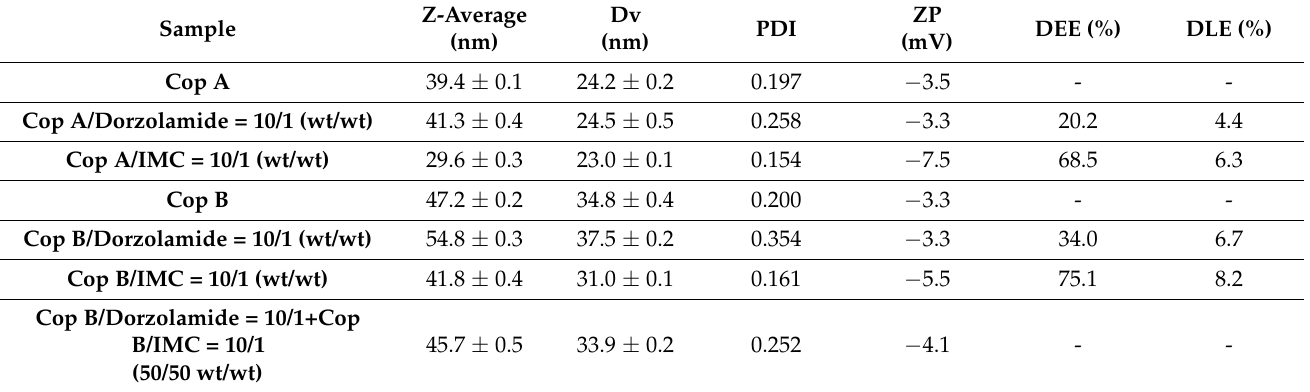
Table 1. Colloidal characteristics of freshly prepared suspensions of Cop A and Cop B micelles in PBS (pH = 7.4) at 25 ◦ C, at a concentration of 0.5 wt%, in the absence of drug, and with a copolymer/drug ratio of